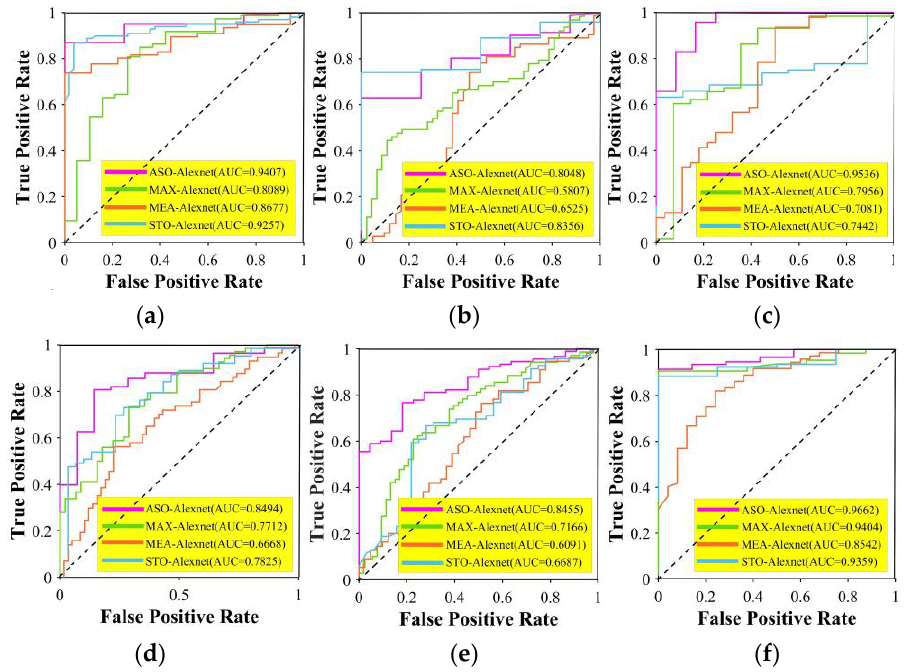
Figure 17. The ROC and AUC values of the four models for six rock categories. ( a ) wackestone; ( b ) granite; ( c ) scholar; ( d ) quartz sandstone; ( e ) conglomerate; ( f ) crystalline dolomite.